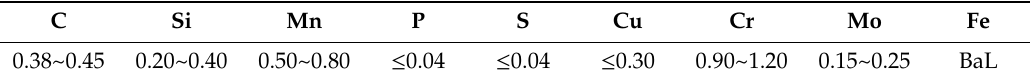
Table 1. Chemical composition of the 42CrMo steel (wt. %).